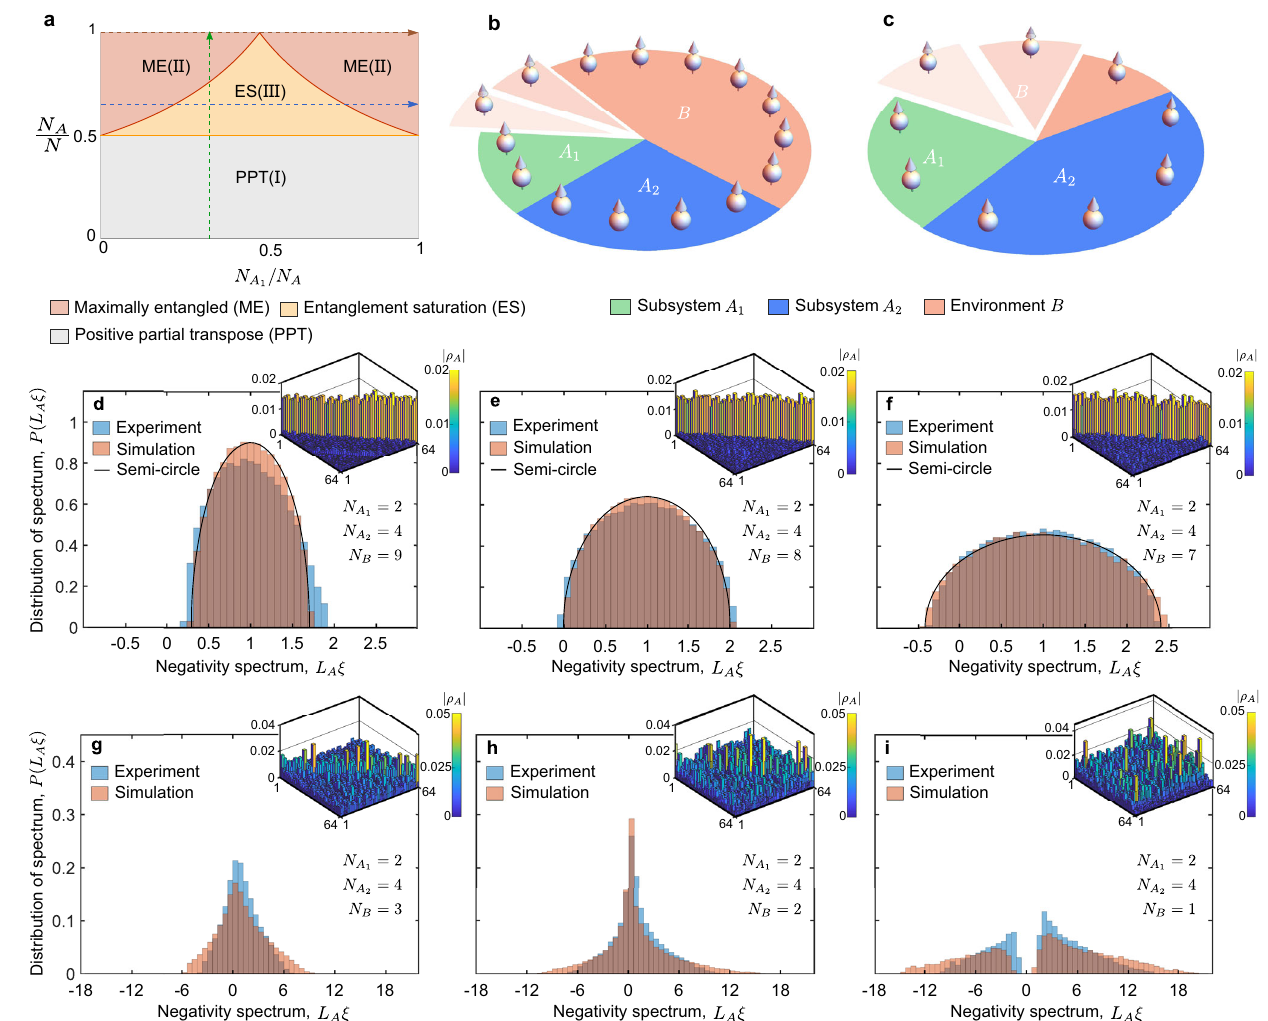
Fig. 2 | Phase diagram and negativity spectra. a Analytical phase diagram of reduceddensitymatrix ρ A when N ! 1 .Greenarrowindicatesapathalongwhich thenegativityisplottedinFig.3a.Blueorbrownarrowsindicatepathsalongwhich the negativity is plotted in Fig. 3b. b, c Cartoons of subsystems and environment. Green, blue, and orange sectors represent subsystems A 1 , A 2 and environment B ,